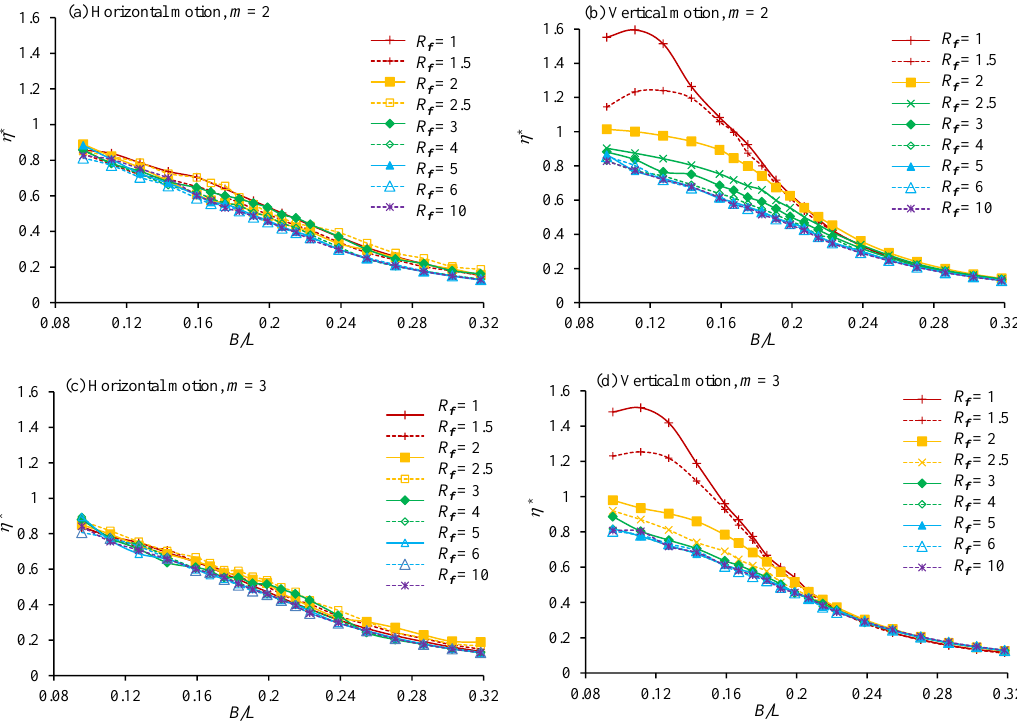
Figure 7. Variation of the amplitude of the waver surface elevation of the floating OWC chamber 𝐵/𝐿 for K t = 3000 Pa·m −3 ·s and d / h = 0.25. If the OWC oscillates vertically, the phase difference between the vertical motions of the OWC and the water surface motion, which is defined as φ , affects the volume change and the efficiency. Figure 8 shows the variation of the phase difference φ with B / L for K t = 3000 Pa·m −3 ·s for the vertical motion of the OWC device. The value of φ is found to con- tinuously increase with the increase of 𝑅 𝑓 until 𝑅 𝑓 = 10 for the vertical motion of OWC device. Both A Y and η * increase if 𝑅 𝑓 decreases, but the largest amplitudes of oscillation and wave surface elevation at 𝑅 𝑓 = 0 produce the smallest power, as shown in Figure 3, because the very small phase 𝜑 difference between them creates a very small change in the OWC volume or air flow rate. With the increase of 𝑅 𝑓 , the increase in 𝜑 is in favour of power generation, but the decreases in 𝐴 𝑌 and η * cause the reduction in power generation. The combination effects of 𝜑 , 𝐴 𝑌 , and η * make the maximum best efficiency occurring at 𝑅 𝑓 = 10, K t = 3000 Pa·m −3 ·s, and d / h = 0.25.